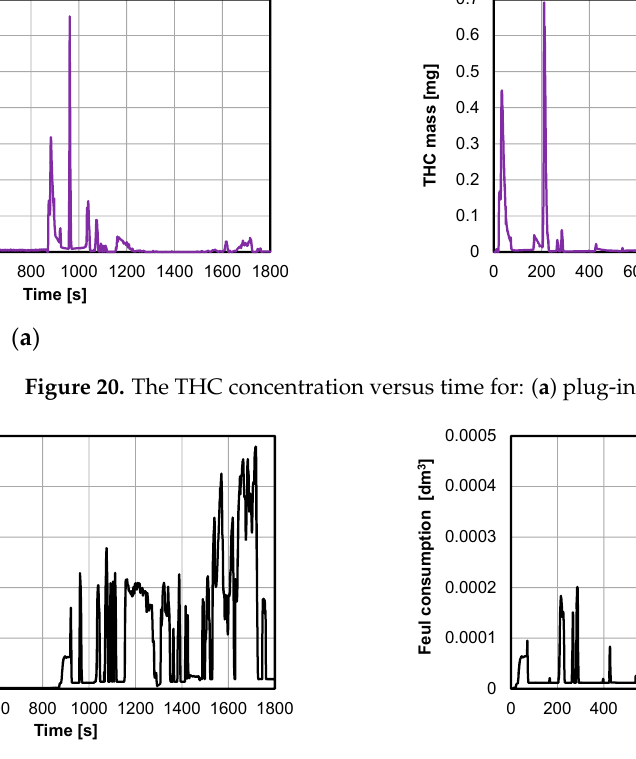
Figure 21. The fuel consumption (FC) versus time for: ( a ) plug-in; ( b ) HEV.